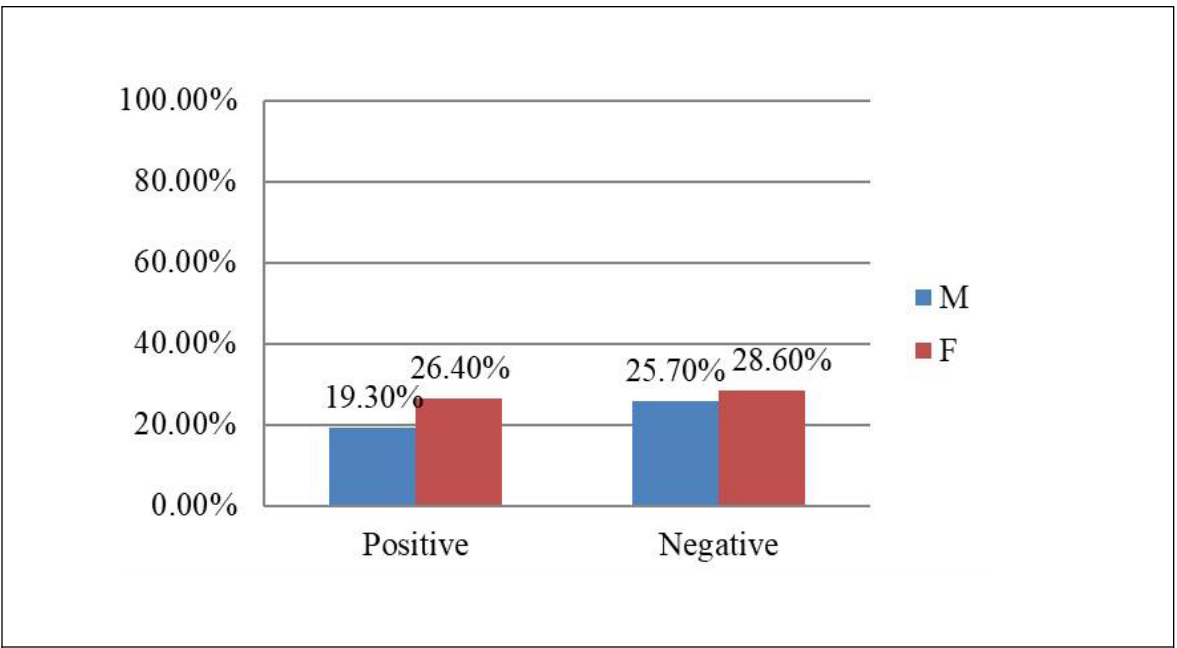
Figure 2: Prevalence of H. pylori infection according to the age groups of patients